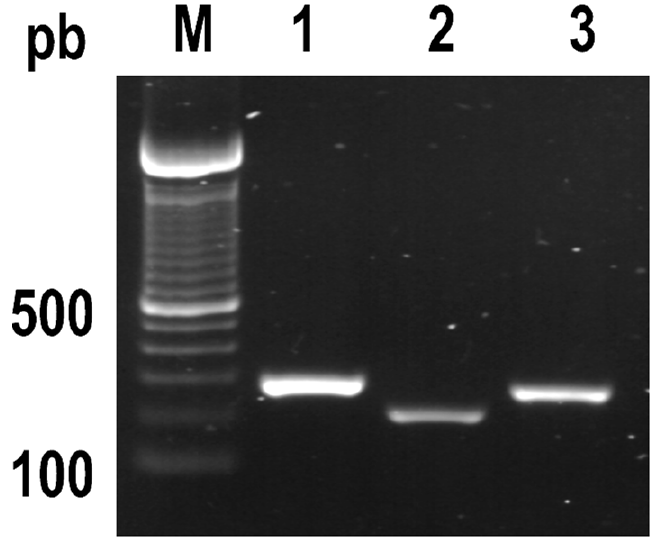
Figure 1. PCR detection of Salmonella Typhimurium virulence genes. Lane 1, invA gene (1322 bp). Lane 2, siiE gene (240 bp), and Lane 3 fliC gene (307 bp). M, DNA ladder, standard molecular size marker.